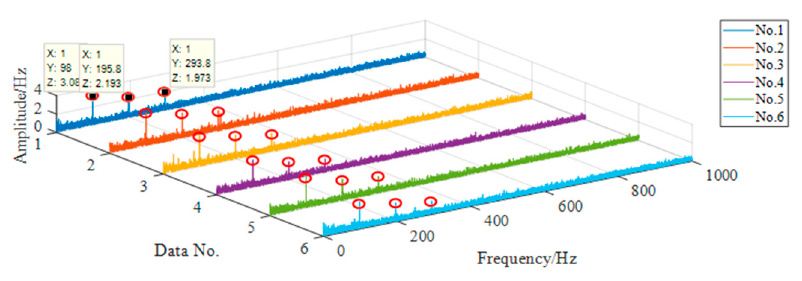
Figure 16. Characteristic frequency distribution of outer ring fault.